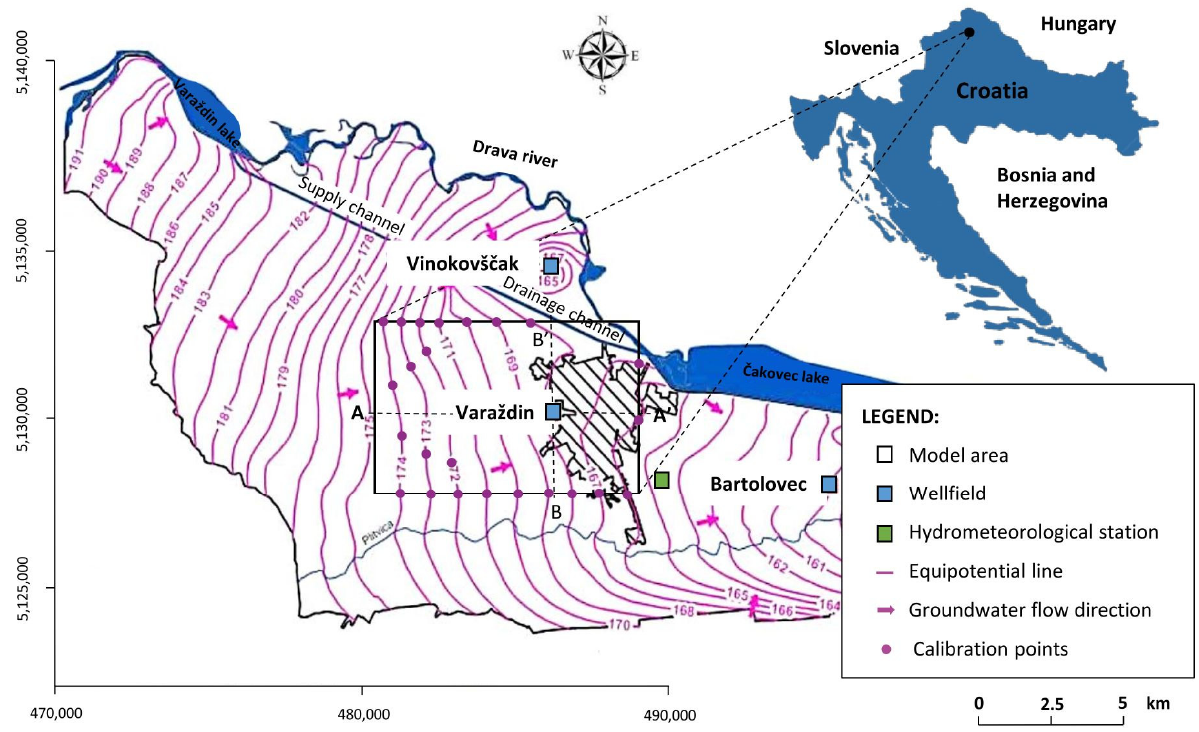
Figure 1. Geographical position of the the Bartolovec, Varaždin and Vinokovšˇcak wellfields, the model area with groundwater equipotential lines calibrated on March 20, 2003 [30].